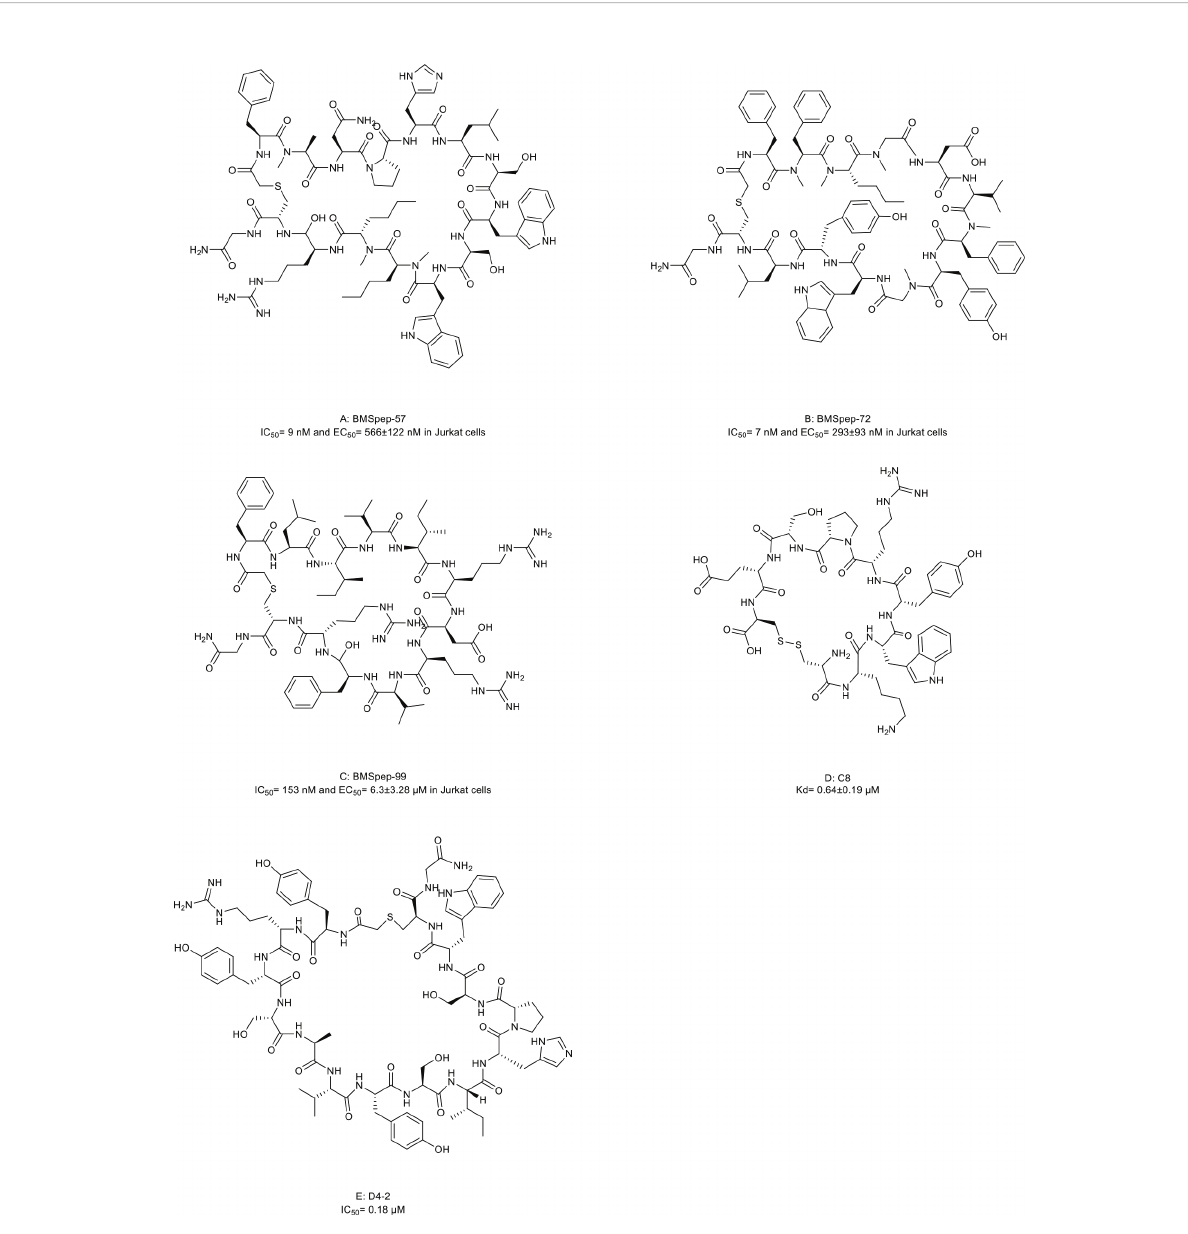
FIGURE 4 Macrocyclic peptides targeting immune checkpoints. (A) BMSpep-57, IC50=9nM and EC50 =566±122 nM in Jurkat cells; (B) BMSpep-71, IC50= 7nM and EC50 =293±93 nM in Jurkat cells; (C) BMSpep-99, IC50=153 nM and EC50 =6.3±3.28 µM in Jurkat cell; (D) C8, Kd=0.64±0.19 µM; (E) D4-2, IC50 = 0.18